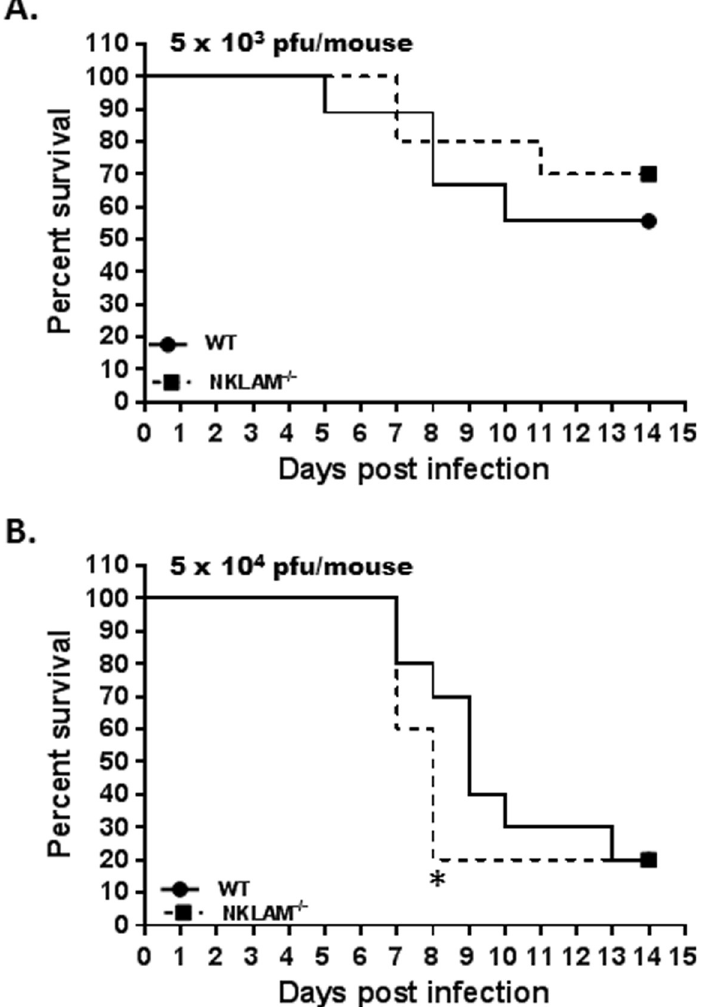
Fig 8. High-dose SeV infection is associated with a faster mortality rate in NKLAM -/- mice. Wild type and NKLAM -/- mice were infected with 5 x 10 3 (A) or 5 x 10 4 (B) pfu SeV/gram body weight and monitored for signs of distress for 14 days. � p < 0.05 at day 8; Log-rank test for significance; n = 10 mice per